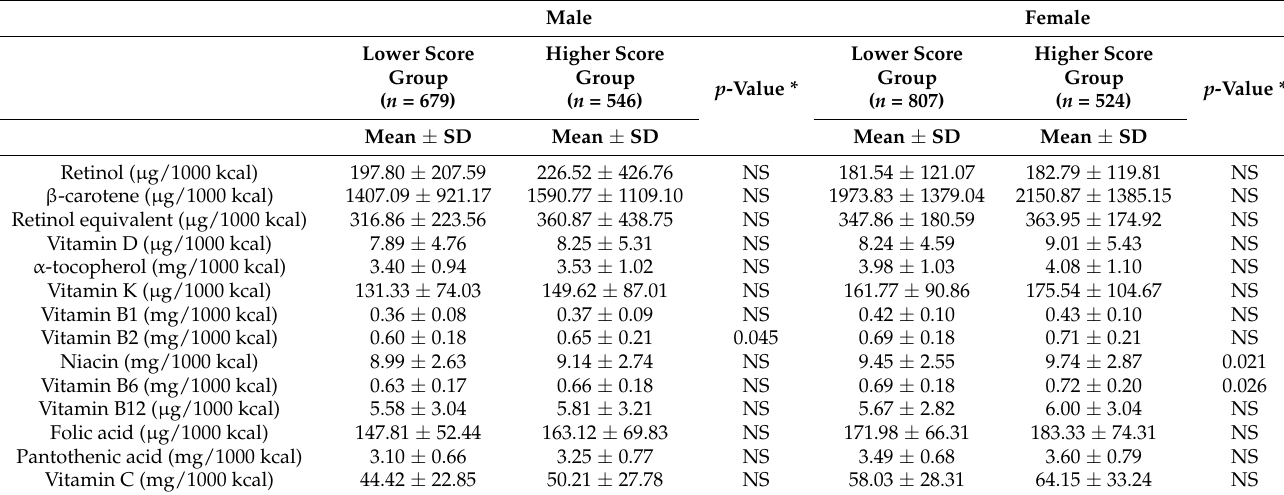
Table 3. Comparisons of the nutrient intakes according to Mental Component Summary (MCS)